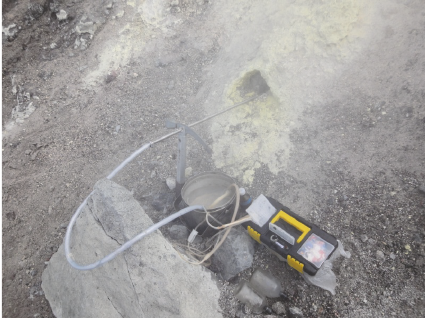
Figure 22: Avachinsky fumarole (FA2) sampling on August 2014. Photo by A. V. Kiryukhin.